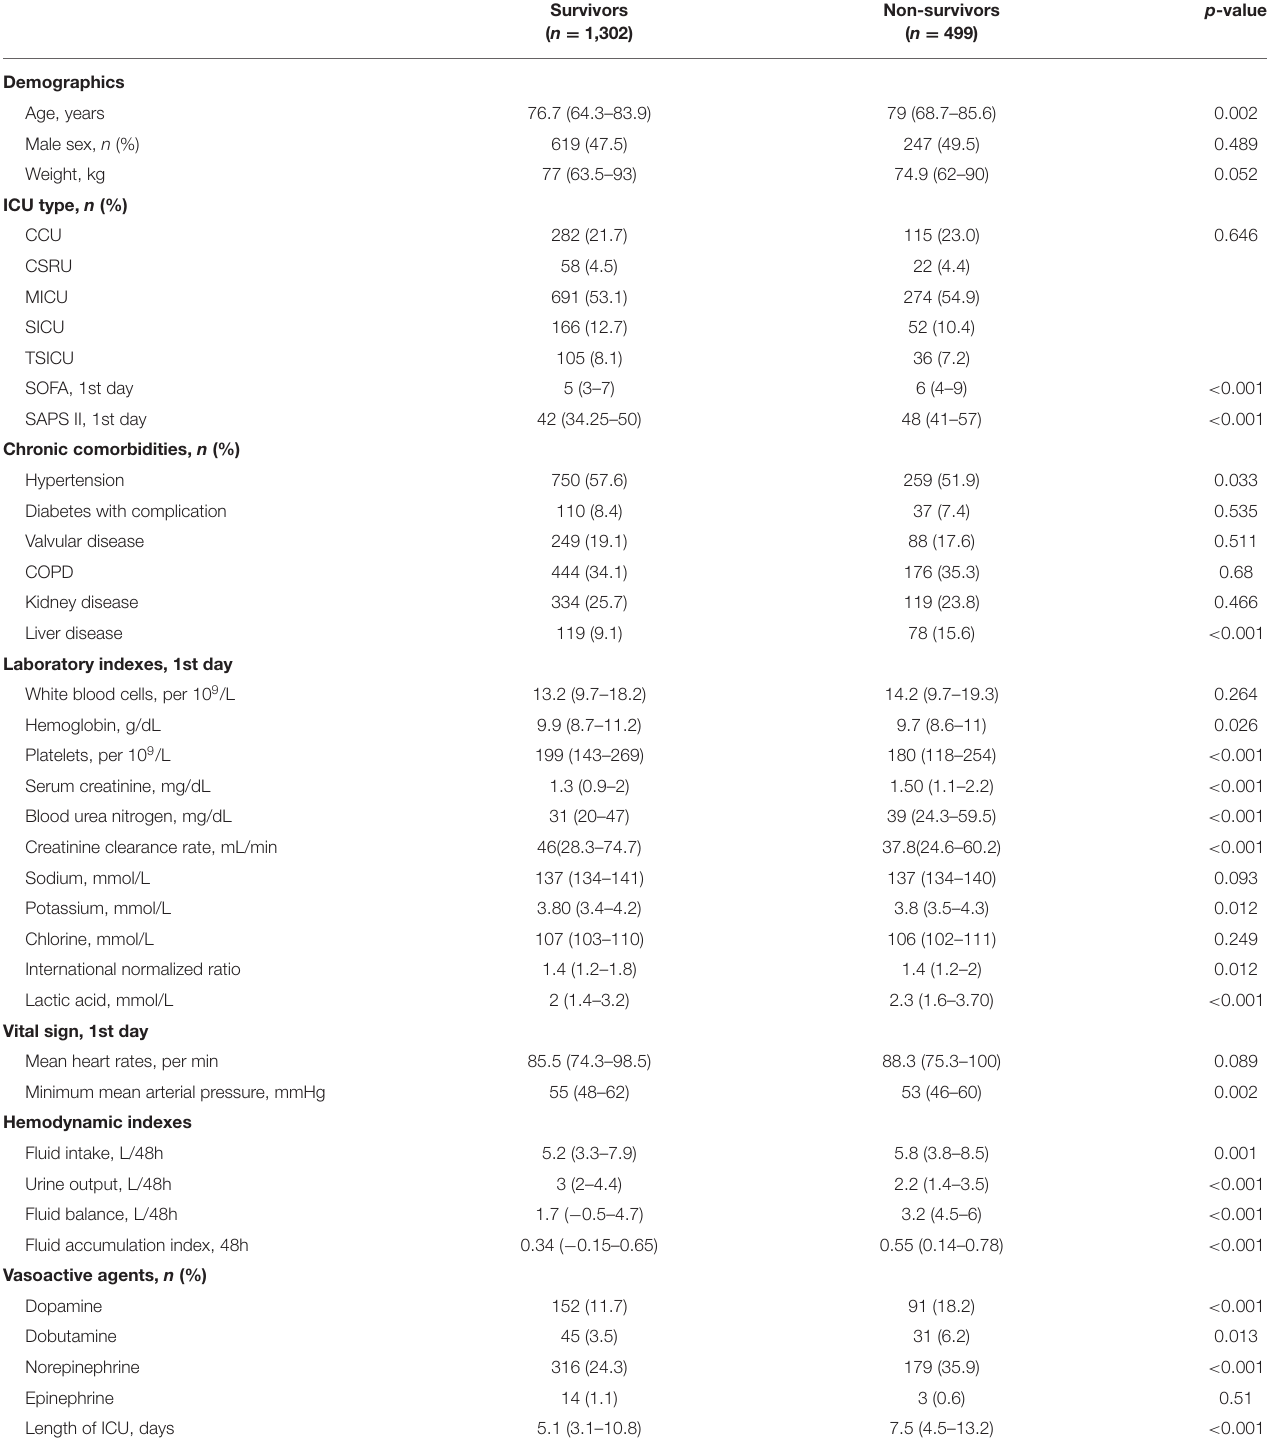
TABLE 1 | Comparison of patient characteristics between survivors and